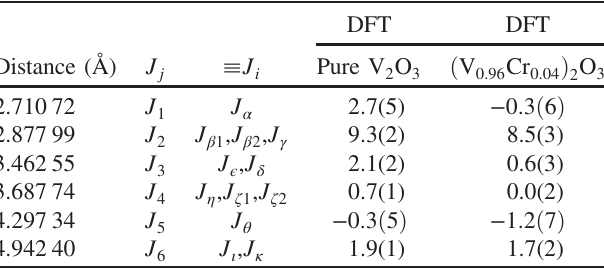
TABLE II. DFT calculated exchange constants (in meV) for the the corresponding exchange constants for the lower-symmetry AFI